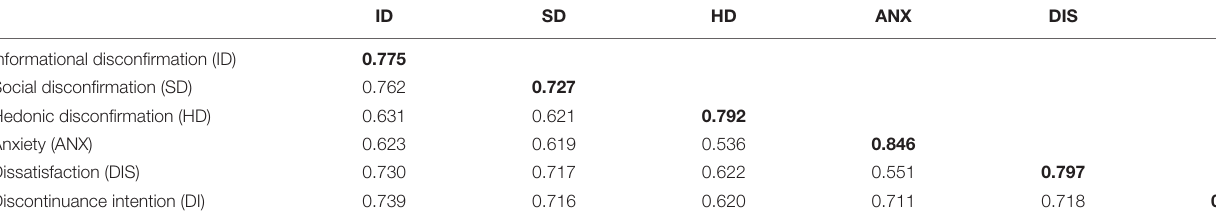
TABLE 3 | The discriminant